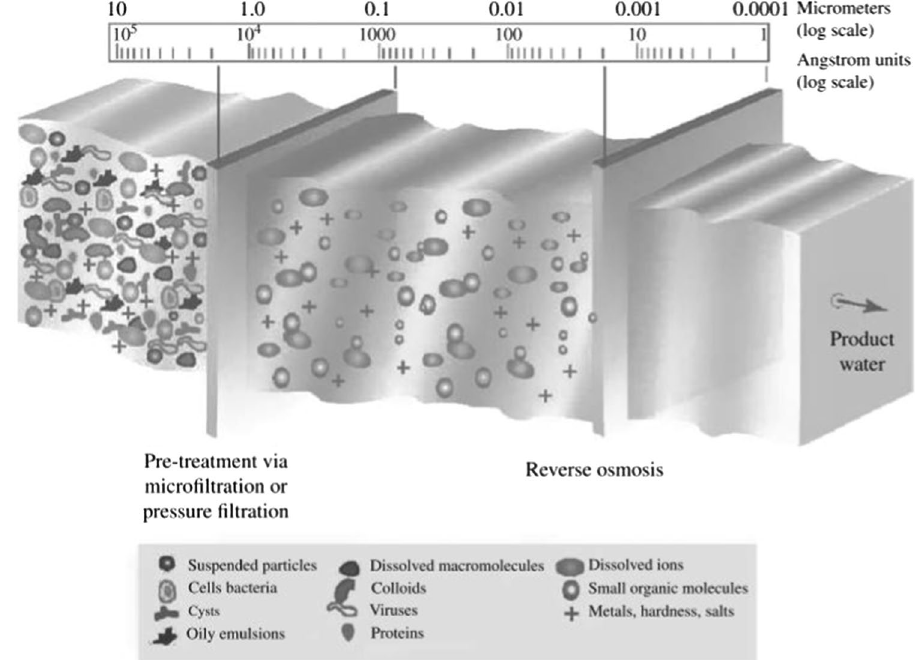
Fig. 10 Ranges of isolated materials by reverse osmosis membrane (Voutchkov